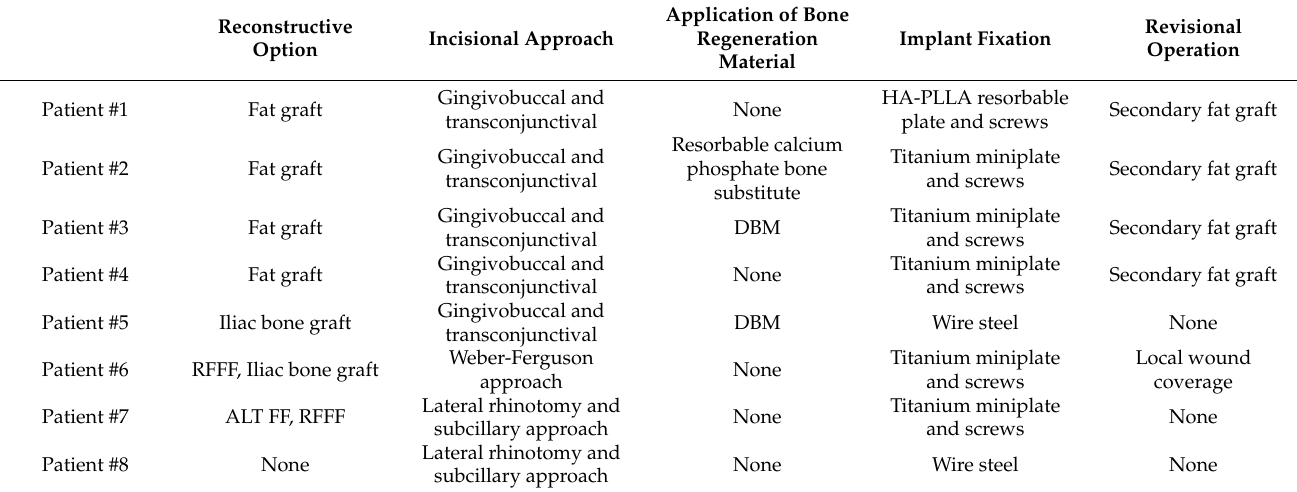
Table 2. Surgical details.